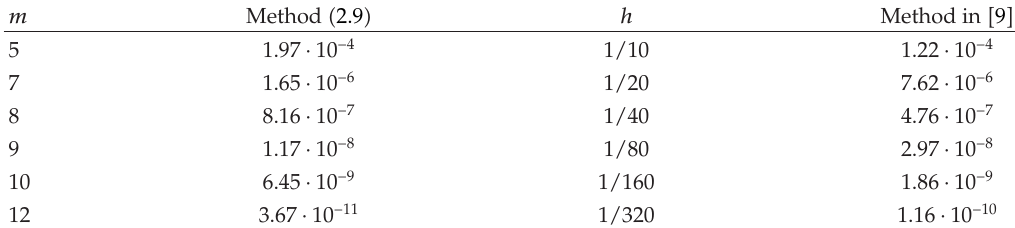
Table 7: Problem (cid:4) 5.8 (cid:5) —Example